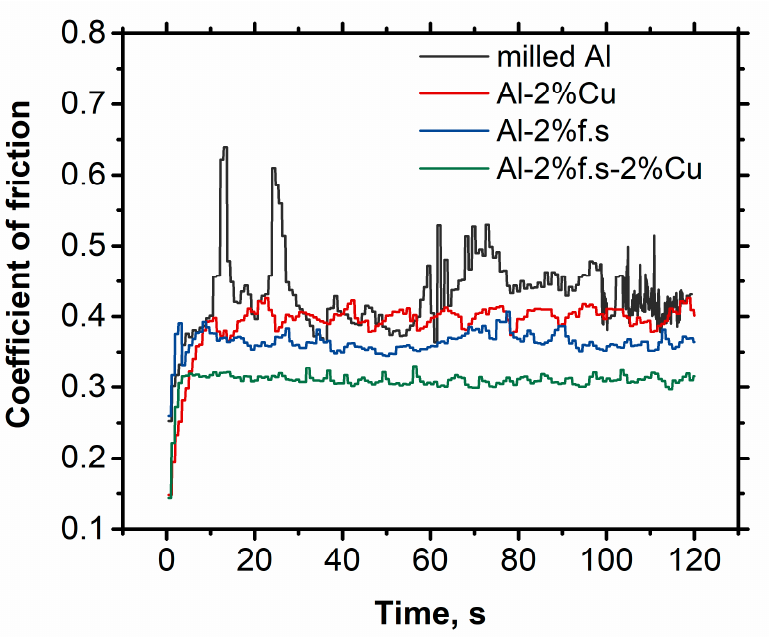
Figure 4. The dependence of the friction coefficient on time at a sliding speed of 0.12 m/s and at a load of 20 N (0.13 MPa).